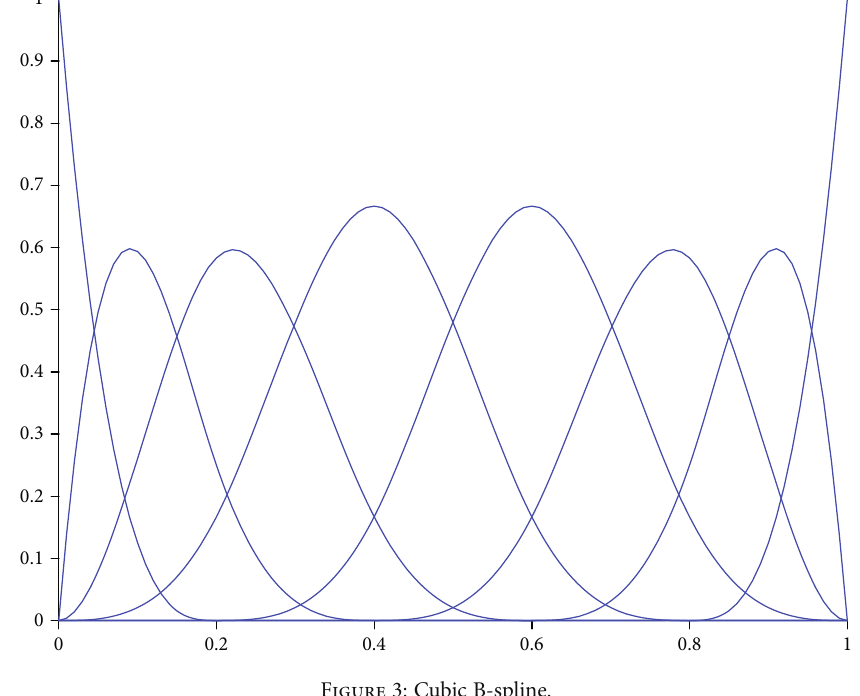
Figure 3: Cubic B-spline.